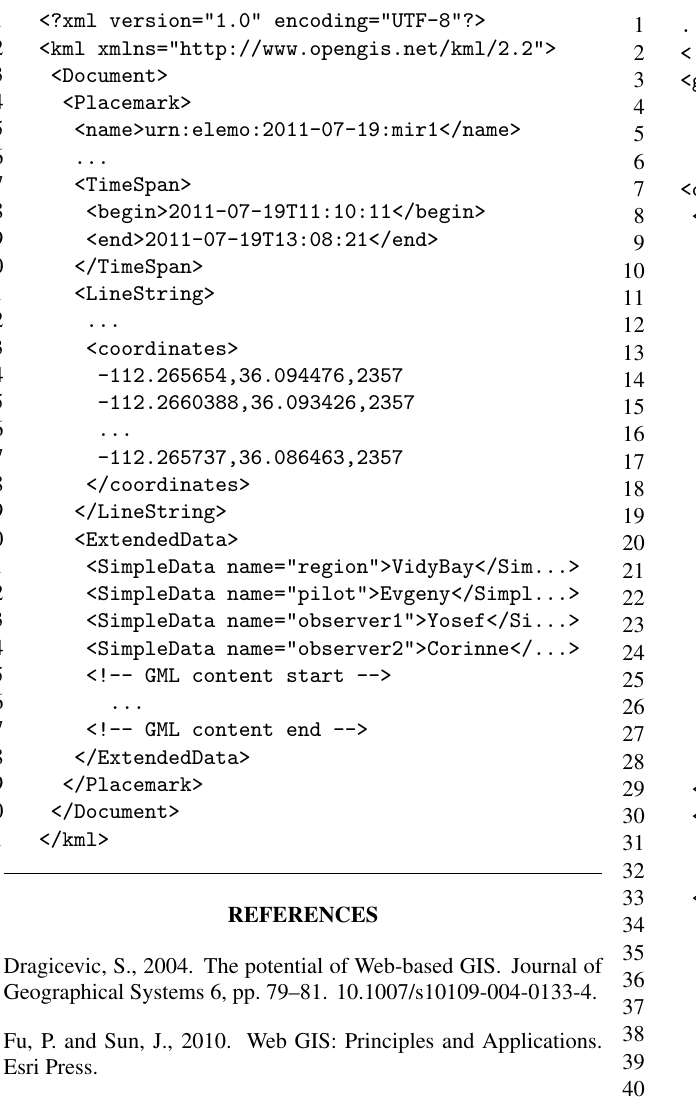
Table 2: Dense sensor data from the ´El´emo field campaign en- coded using OGC GML Observations-and-Measurements (OM, 2011) and Sensor Web Enablement (SWE, 2011) frameworks and embedded within a KML file, as portrayed in Table